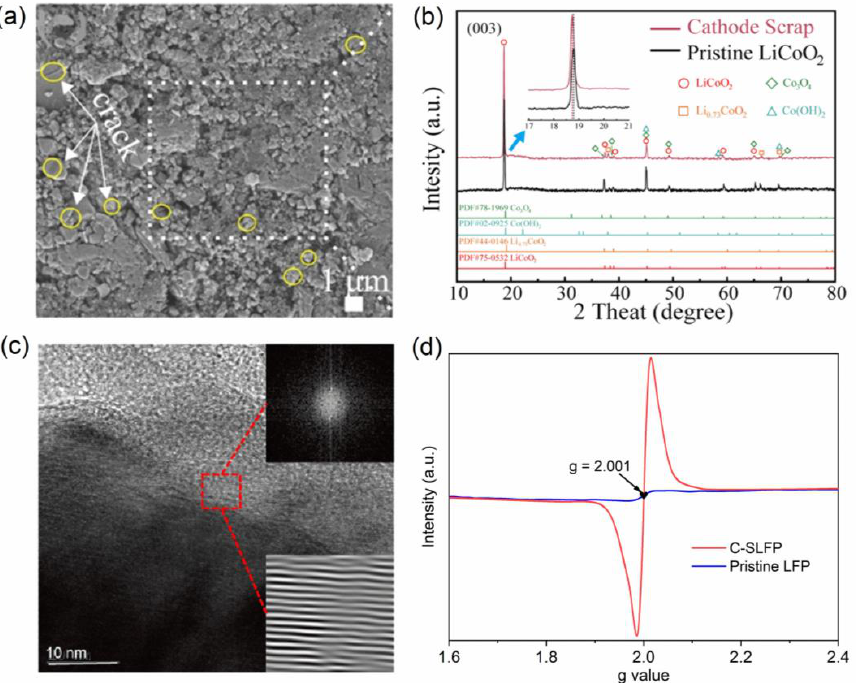
Figure 4. ( a ) SEM image of the recycled cathode scrap surface, ( b ) XRD patterns of pristine LiCoO 2 and cathode scrap, ( c ) the TEMs characterization of SLFP, and ( d ) EPR profiles of SLFP and pristine LFP catalysts. Reprinted with permission from Refs. [45,66,72].